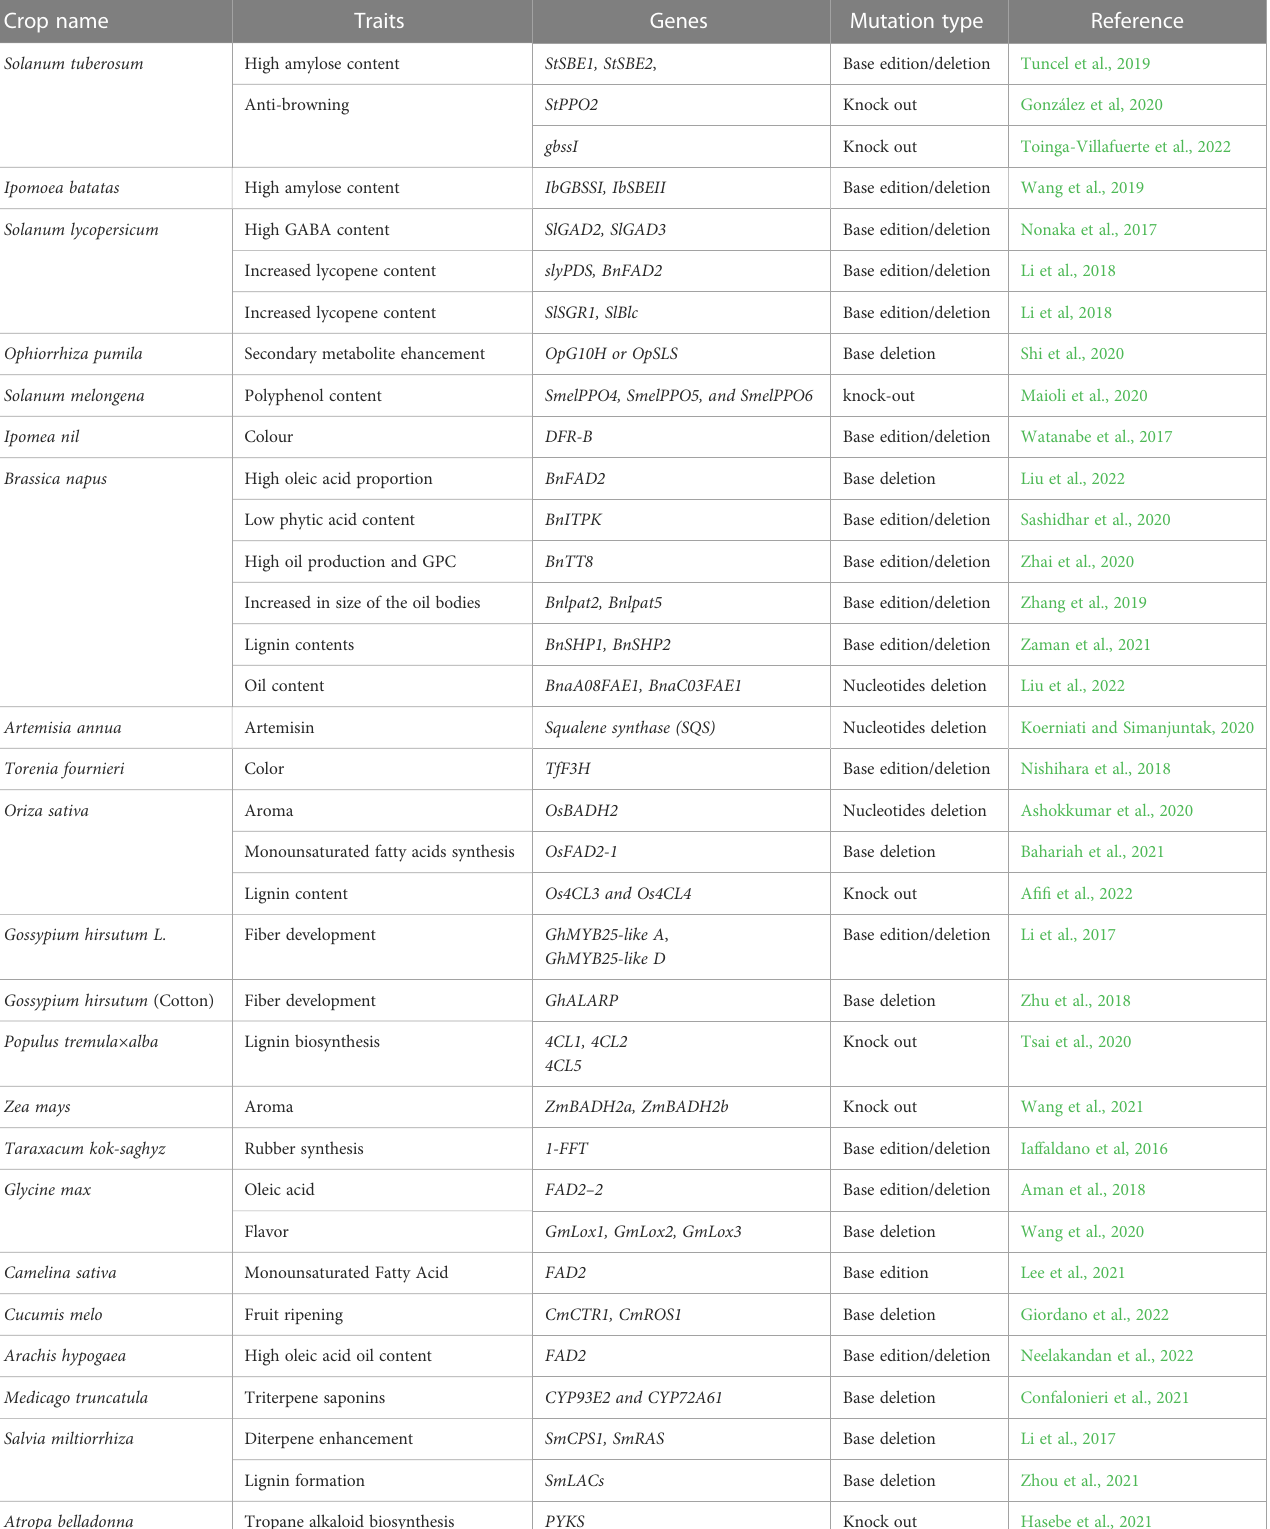
TABLE 1 Examples of the application of CRISPR-Cas technology in diverse crops species (cereal, fruit, vegetable, ornamentals, and medicinal crops) for consumer speci fi c commercial trait